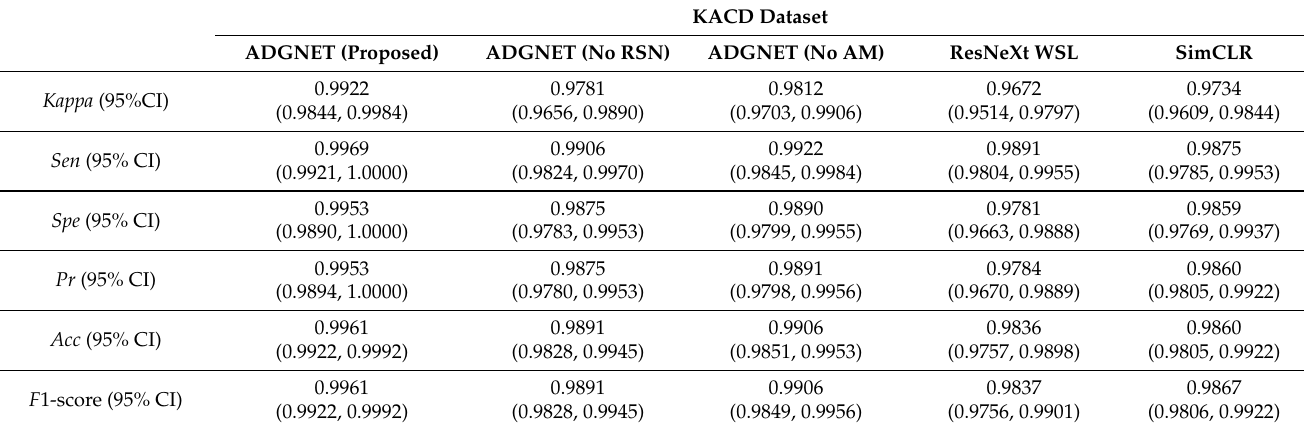
Table 2. Performance indices of the proposed ADGNET framework of the experiment A and the average performance of the two state-of-the-art (SOTA) models on the KACD dataset.